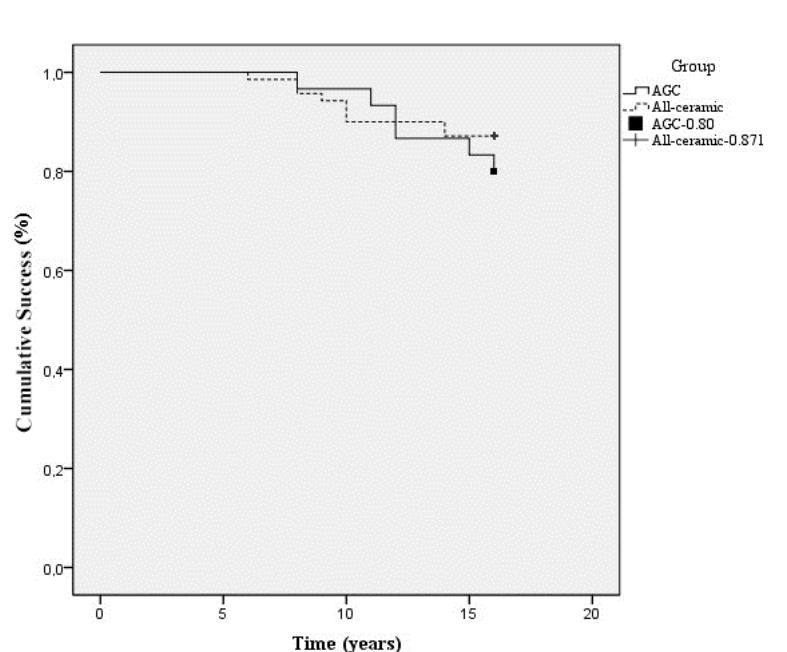
Figure 9. Kaplan–Meier graph showing cumulative success rates in relation to time. Two different curves were reported for patients wearing AGC and all-ceramic crowns,